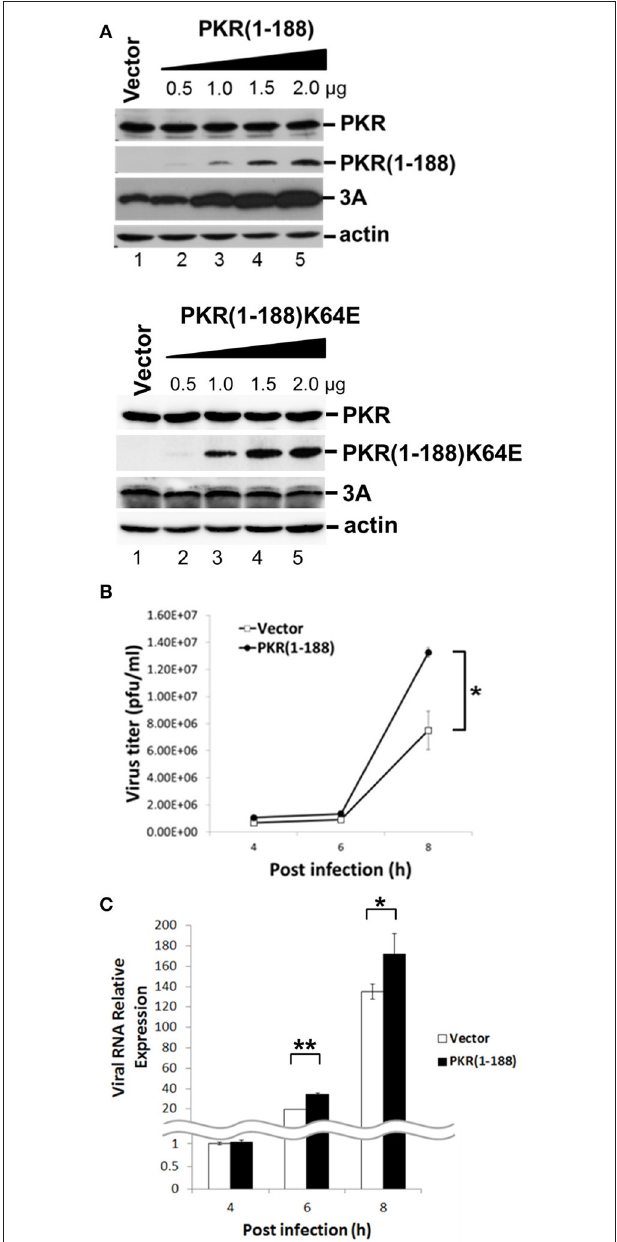
FIGURE 7 | The fragment amino acids 1–188 of PKR facilitates virus replication. (A) RD cells were transfected with the vector, increasing concentrations of plasmids encoding the PKR(1–188) or PKR(1–188)K64E fragment. At 48 h after transfection, the cells were infected with EV-A71 at an m.o.i. of 10 for another 8 h. The cell extracts were analyzed by immunoblotting using anti-PKR, anti-3A and anti-actin antibodies. PKR(1–188) was detected with anti-PKR antibody. Actin expression was used as a protein loading control. A representative result from at least three reproducible experiments is shown. (B,C) RD cells were transfected with the vector or of plasmids encoding the PKR (1–188) fragment. At 48 h after transfection, the cells were infected with EV-A71 at an m.o.i. of 10 and then the culture supernatant was harvested at 4, 6, and 8 h p.i. for virus titer determination by plaque assay (B) ; and the total RNA was extracted for intracellular EV-A71 RNA quantification by RT-qPCR (C) . GAPDH mRNA quantification was used for normalization. The results are expressed as the mean ± SD ( n = 3). * p < 0.05; ** p <